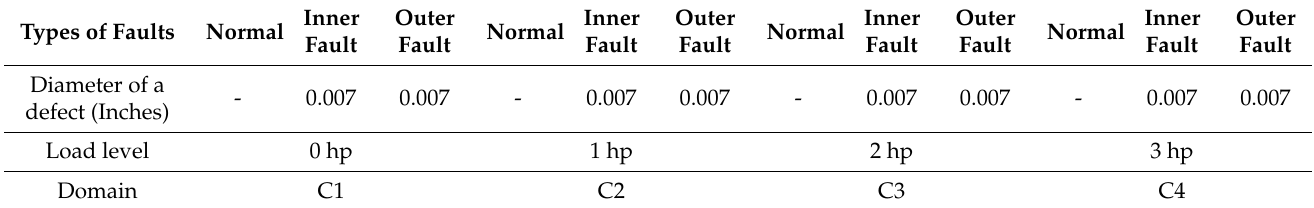
Figure 3. Testbed of CWRU data (electric motor, torque transducer, encoder, and dynamometer and control electronics) [2]. Table 1. CWRU dataset used in the paper and domain description.